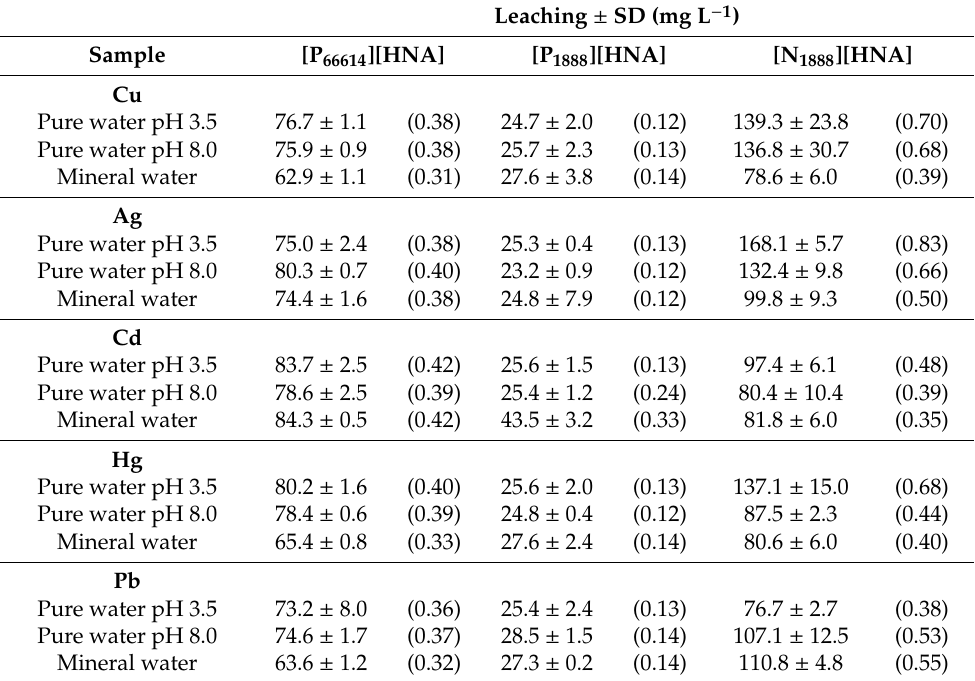
Table 3. Leaching of the respective ionic liquid into the aqueous feed solution during extraction for an extraction time of 2 h; percentage of dissolution given in brackets, n =